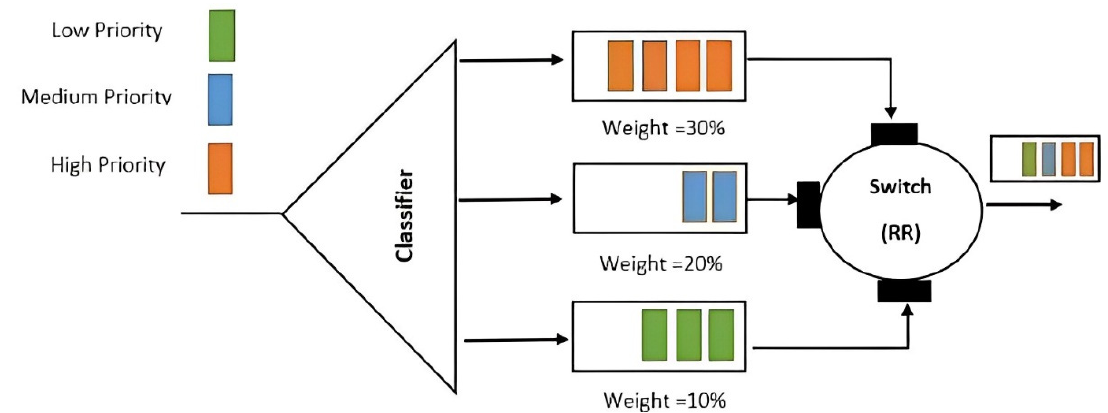
Figure 8. Classifier Mechanism